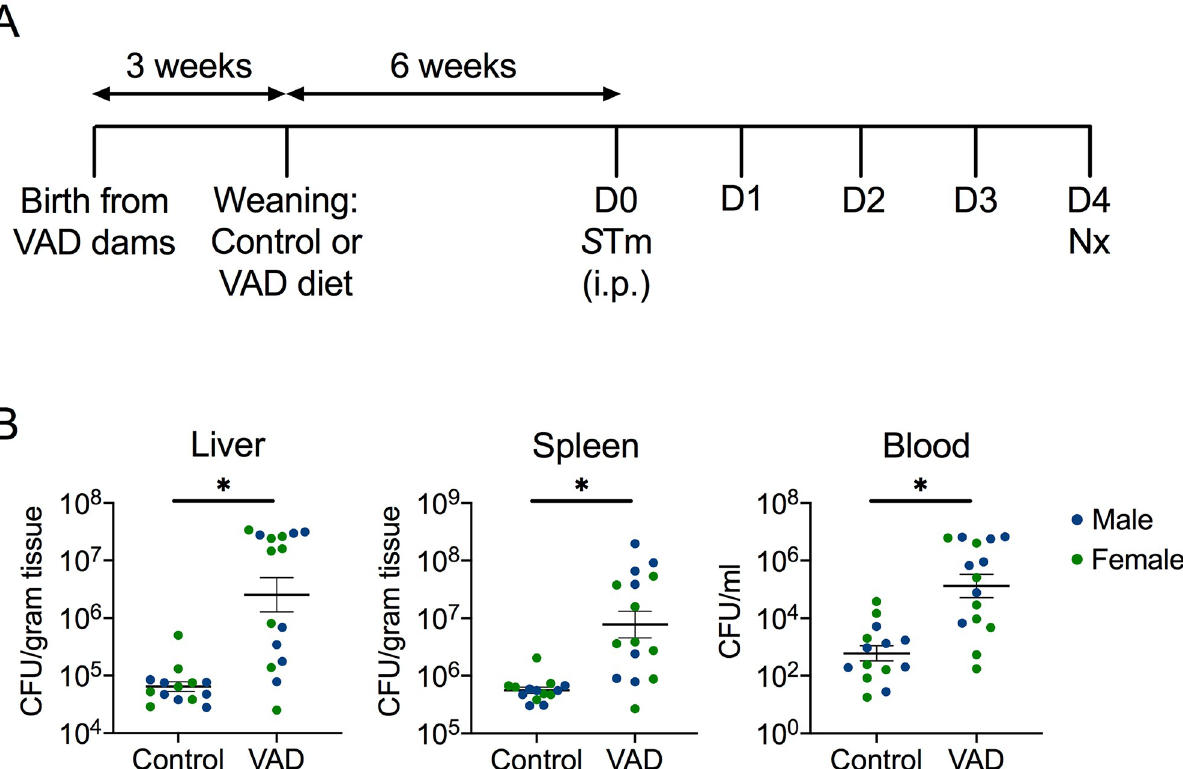
Fig 1. Systemic burden of Salmonella is higher in vitamin A-deficient mice. To generate vitamin A-deficient (VAD) mice, C57BL/6 Slc11a1 +/+ pregnant mice were put on a VAD diet 2 weeks into gestation ( A ). At 3 weeks, pups were weaned onto either a VAD or control diet. Male (n = 7) and female (n = 7–8) mice on each diet were infected with S . Typhimurium ( S Tm) D23580 via the intraperitoneal (i.p.) route at 9 weeks of age and systemic bacterial burden was characterized by colony-forming units (CFU) in liver, spleen and blood collected at necropsy (Nx) 4 days after infection ( B ). Data represent mean ± SEM. Significance between control and VAD mice was determined with a Mann-Whitney test of log-transformed values. A p < 0.05 was considered significant.